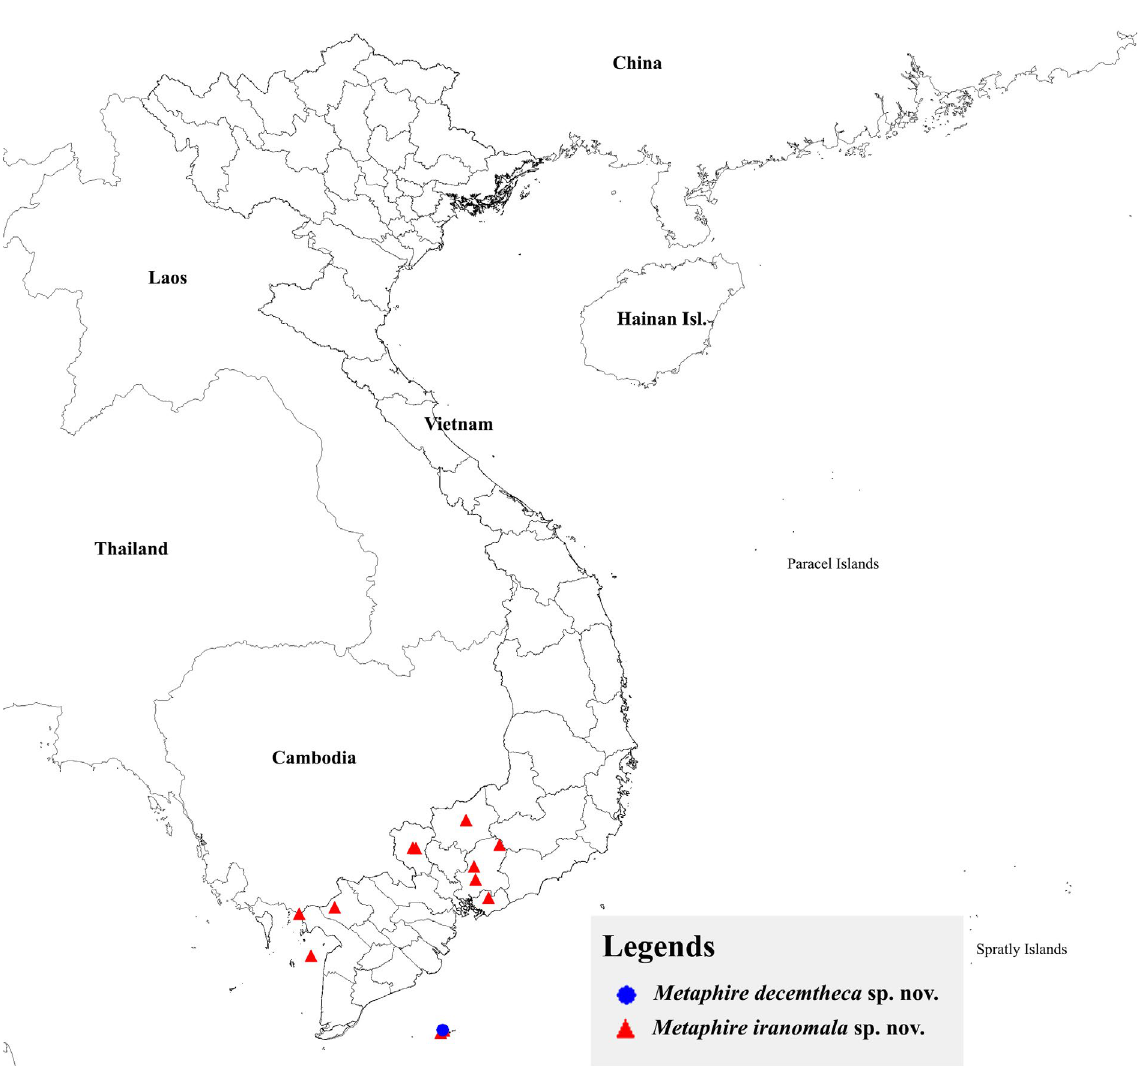
Fig. 3. The distribution of the two new species in Southern